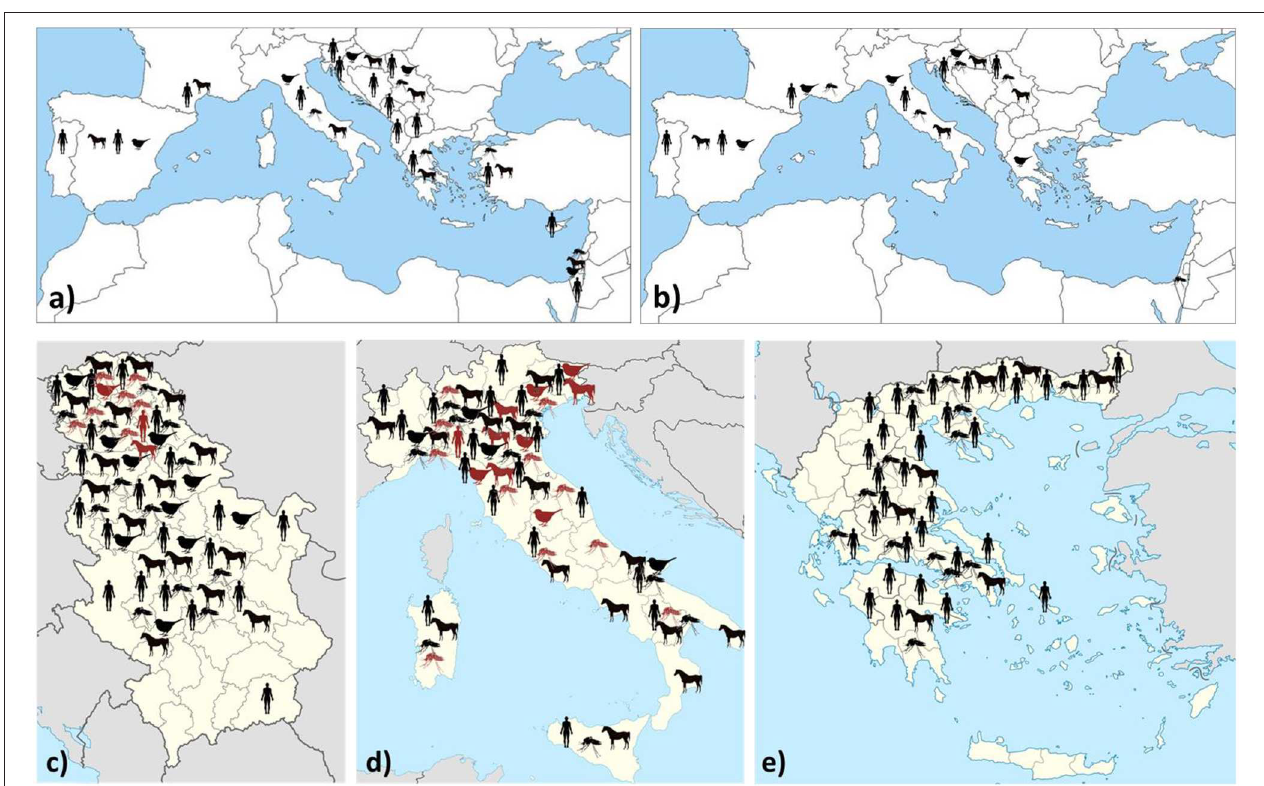
FIGURE 1 | Geographic distribution of WNV (a) and USUV (b) infections/seropositivity in southern Europe and neighboring countries. Regional distribution of WNV (black) and USUV (red) infections (clinical cases/IgM detection/seroconversion/RNA detection) in countries with a high prevalence: Serbia (c) , Italy (d) , and Greece (e) .